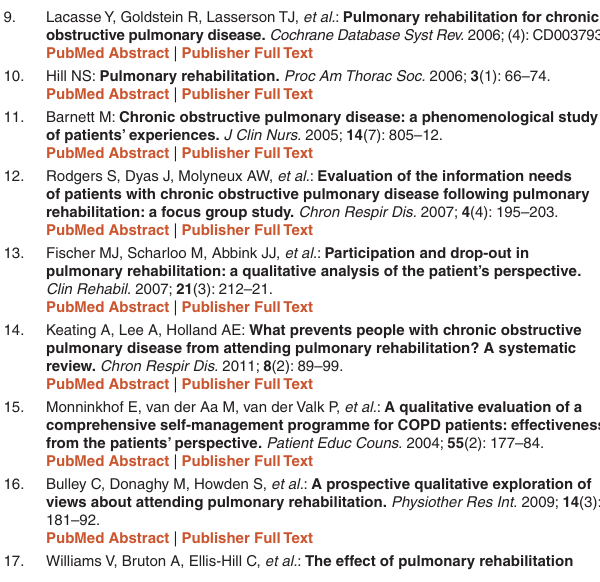
Figshare : Nominal Group Technique consultation of a Pulmonary Rehabilitation Programme Data Set, doi: 10.6084/m9.figshare.928540 31 Consent All participants provided written informed